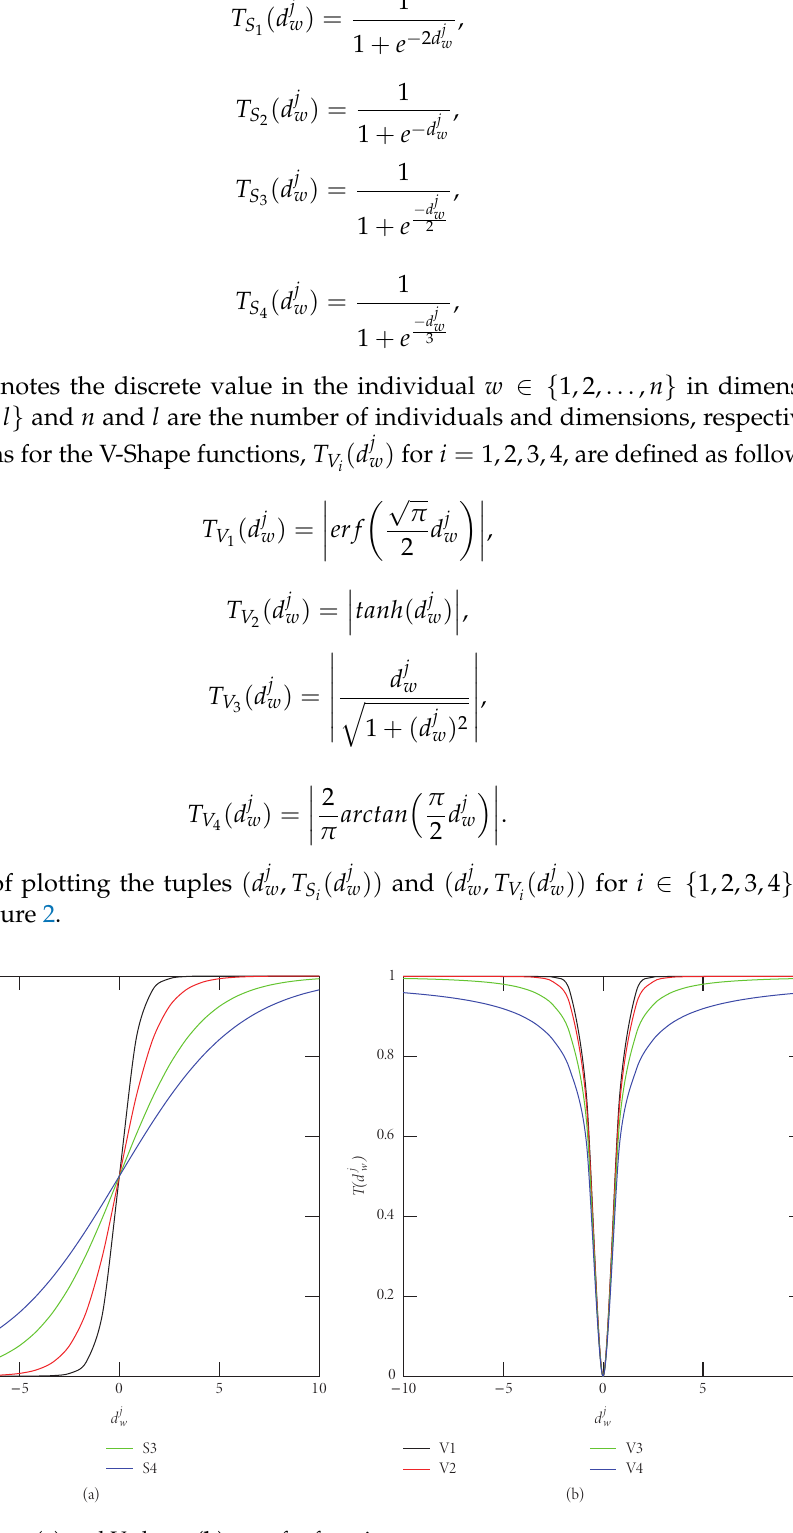
Figure 2. S-shape ( a ) and V-shape ( b ) transfer